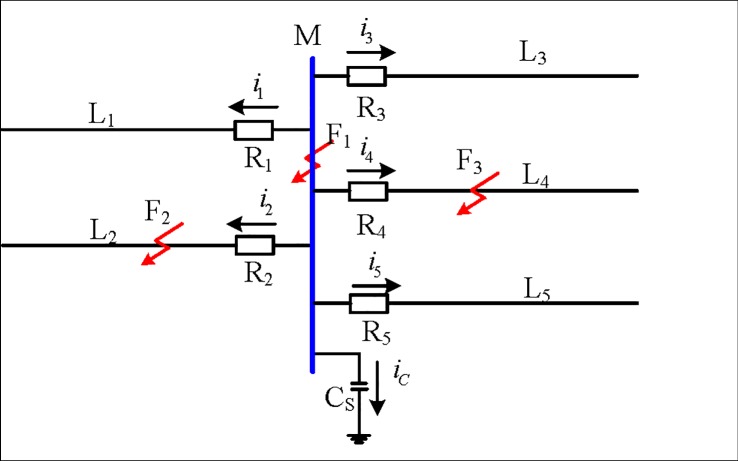
500kV busbar system.